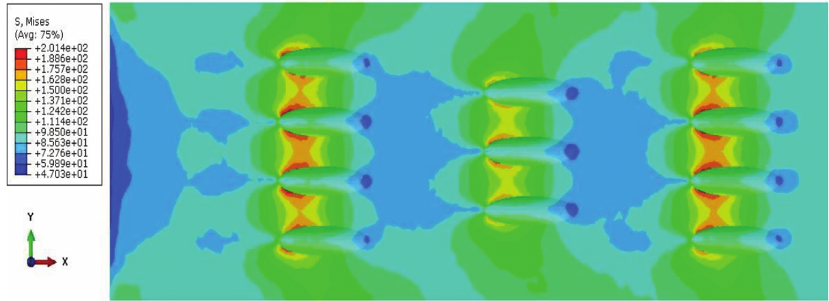
Figure 6: Distribution of equivalent stress when calculation